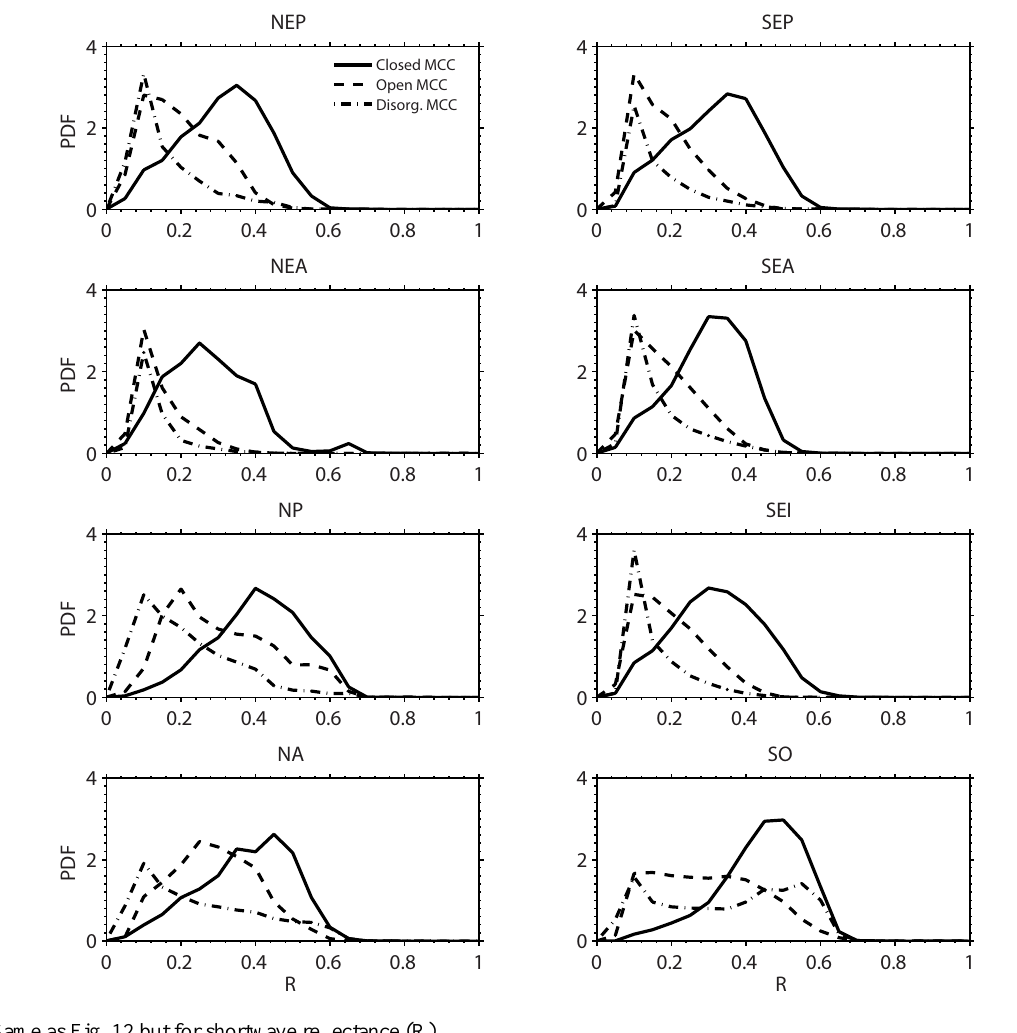
Figure 15. Same as Fig. 12 but for shortwave reflectance